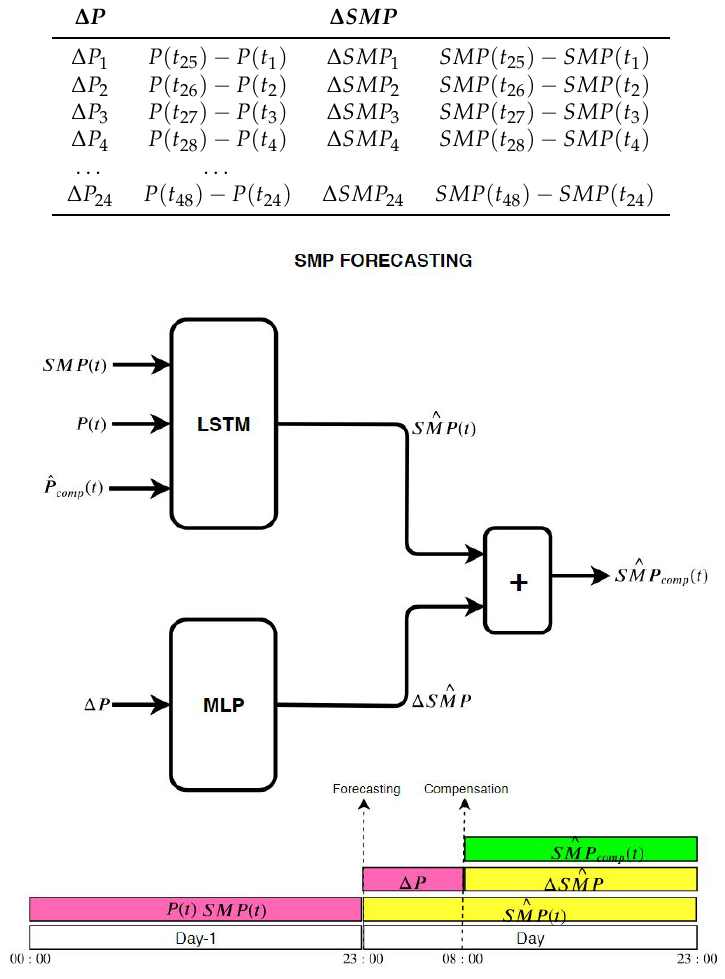
Figure 6. Description of the proposed system marginal price (SMP) forecasting